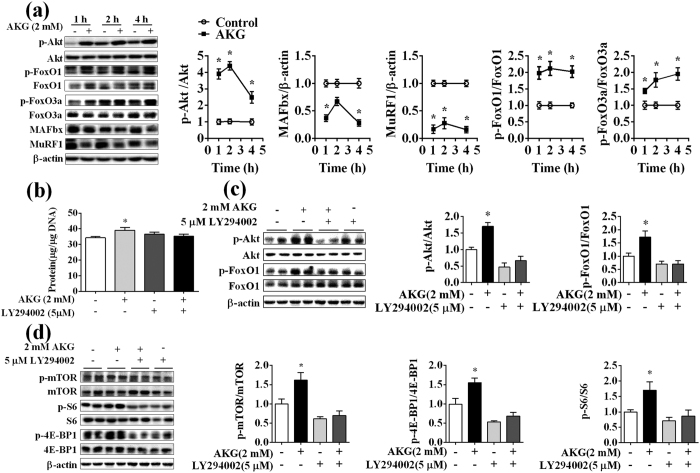
Akt was required to enable AKG to activate mTOR signaling pathway and promote protein synthesis in C2C12 myotubes.(a) C2C12 myotubes were treated with AKG (2 mM) for 1, 2, and 4 h. The expression levels of MuRF1 and MAFbx and the phosphorylation of Akt FoxO1 and FoxO3a were then detected by Western blot. (b) C2C12 cells were cultured for 6 d in a differentiation medium. Akt inhibitor LY294002 (5 μM) was used alone or co-treated with AKG (2 mM) for 48 h. Total protein levels were detected. (c) The phosphorylation levels of Akt and FoxO1 by Western blot in C2C12 myotubes co-treated with AKG and LY294002. (d) The phosphorylation levels of mTOR, S6 and 4E-BP1 by Western blot in C2C12 myotubes co-treated with AKG and LY294002. Data are presented as mean ± SEM. *means P < 0.05 compared with the control. β-actin served as a housekeeping gene control.